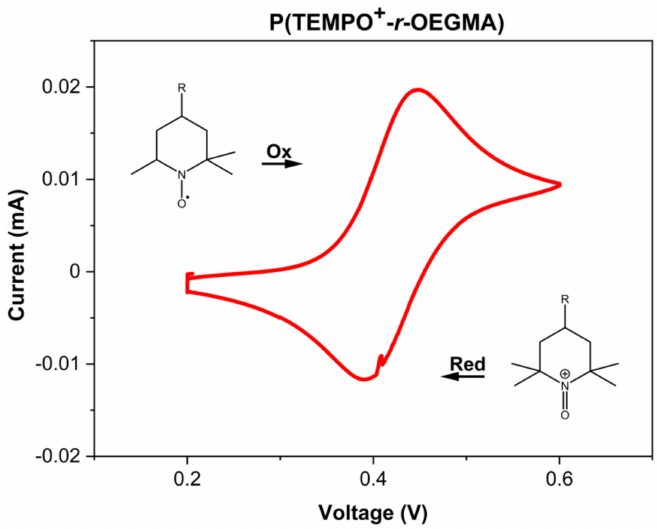
Figure 3. Cyclic voltammetry of P(TEMPO + - r -OEGMA) hydrogels. Analyses conducted in 0.1 M NaClO 4 in distilled water at a carbon electrode. Scan rate = 5 mV s − 1 .